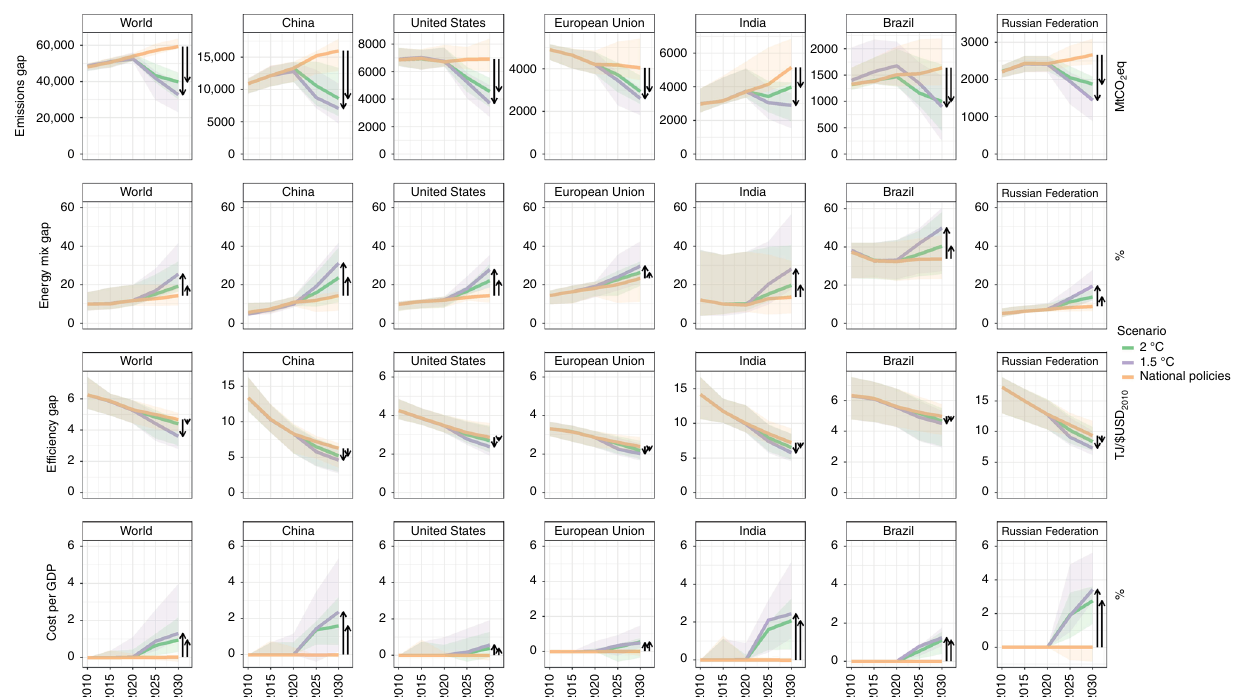
Fig. 3 Indicators derived from Kaya identity and costs per GDP between 2010 and 2030 on a global level and for seven large countries under different scenarios. The median (lines) and 10th – 90th percentile ranges (areas) from nine integrated global assessment models on emissions, energy mix and ef fi ciency gaps and mitigation costs per GDP. These gaps are represented by total greenhouse gas emissions (MtCO 2 eq), low-carbon share of fi nal energy (%), fi nal energy intensity in GDP (TJ/USD 2010 ) and total mitigation costs per GDP (%) between national policies and well below 2 °C scenarios. The